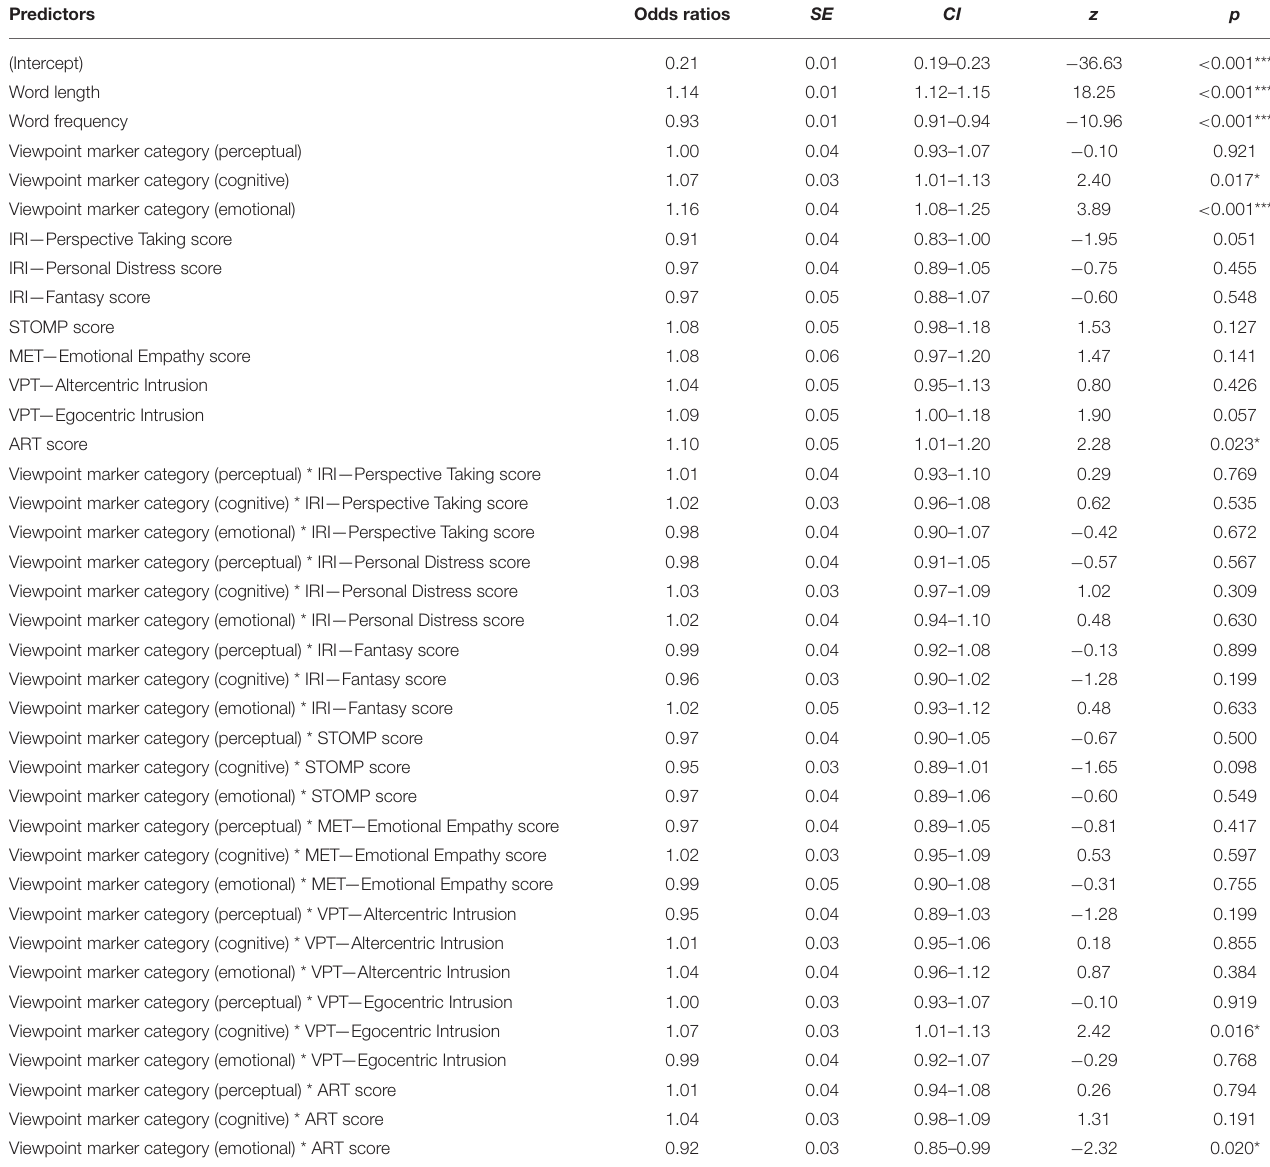
TABLE 6 | Estimates for the generalized linear mixed model predicting rereading rate.